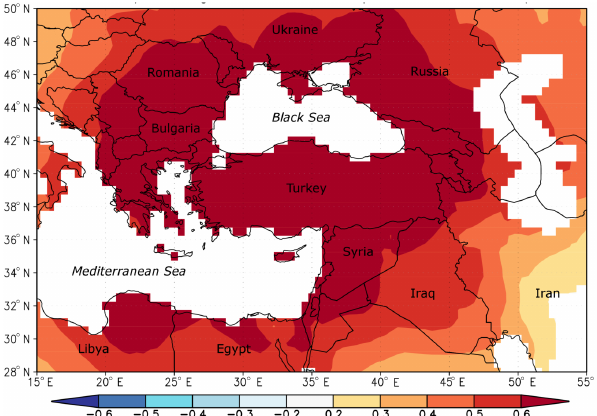
Figure 7. Spatial correlation map for the March–April temperature reconstruction. Spatial field correlation map showing statistical re- lationship between the temperature reconstruction and the gridded temperature field at 0.5 ◦ intervals (CRU TS3.23; Jones and Harris, 2008) during the period 1930–2002 over the Mediterranean region. For each grid, calculated correlation coefficient from 0.20 to 0.60 is significant ( p